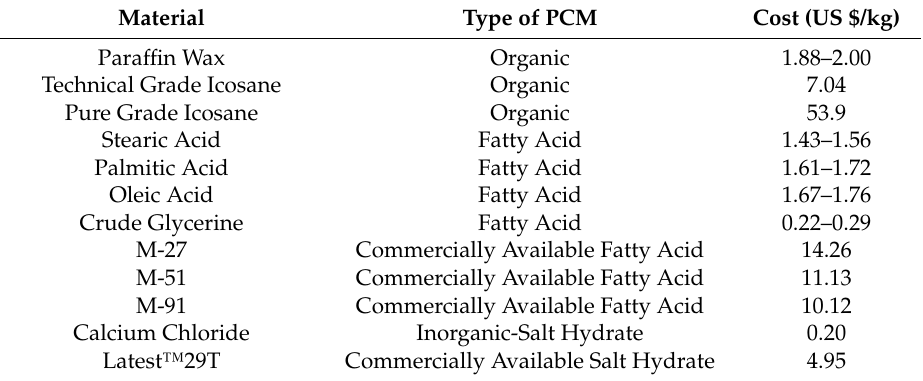
Table 3. Cost of Phase Change Materials